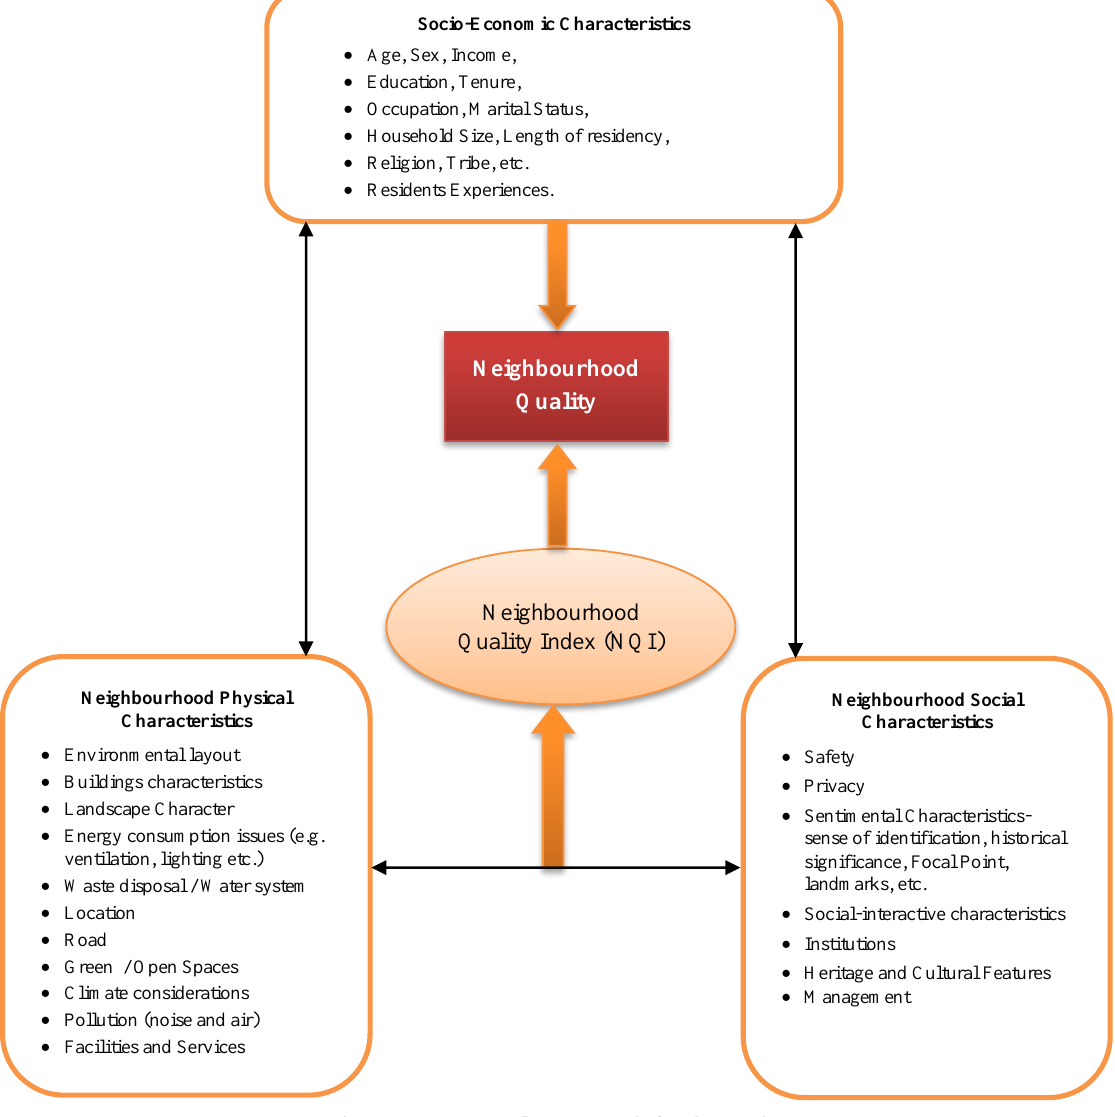
Figure 3. Conceptual Framework for the